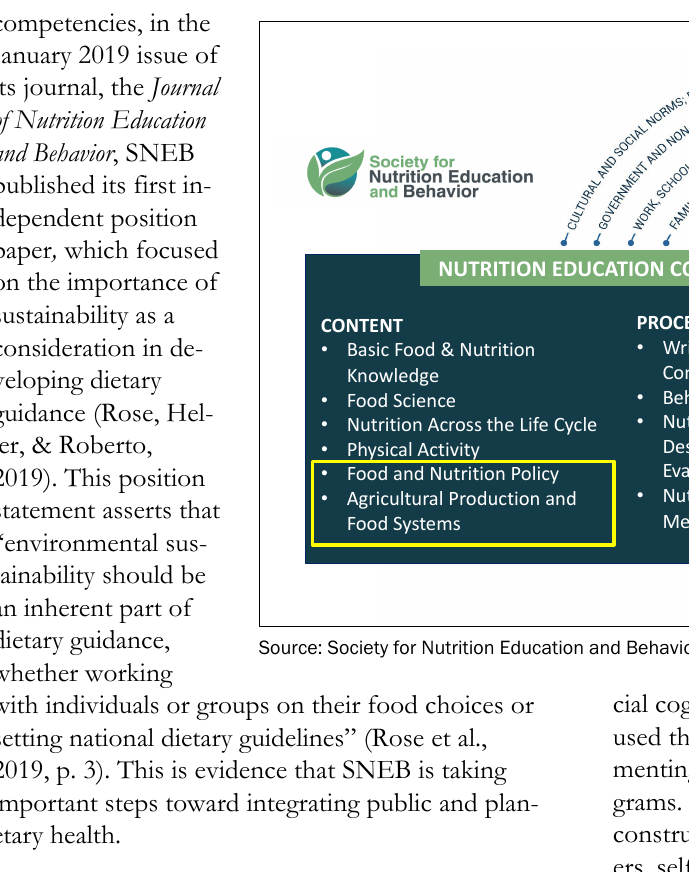
Figure 5. Society for Nutrition Education and Behavior Nutrition Educator Compe- tencies for Promoting Healthy Individuals, Communities, and Food Systems